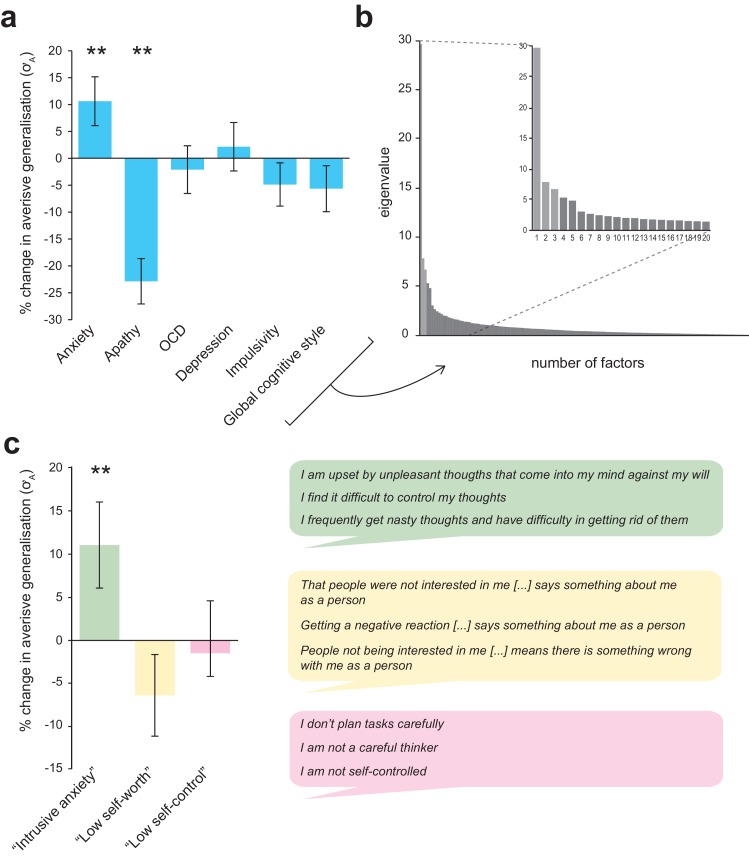
Associations between individual differences in aversive generalization and psychological symptom scores.(a) Percentage change in the model parameter governing width of generalization from aversive feedback (σA) with a one standard deviation increase in total score on each individual questionnaire measure used (individual regression models). (b) Scree plot indicating results of a factor analysis in which all response items from these measures (N = 142) were entered (inset, first 20 factors). A three-factor solution (lighter shaded bars) was indicated as the most parsimonious structure. (c) Percentage change in σA with an increase in 1 SD for each of the factor analysis-derived symptom scores (single regression model). The right hand panel shows the top three loading items for each factor, which were used to derive factor labels. Error bars represent standard error. **p≤0.009.